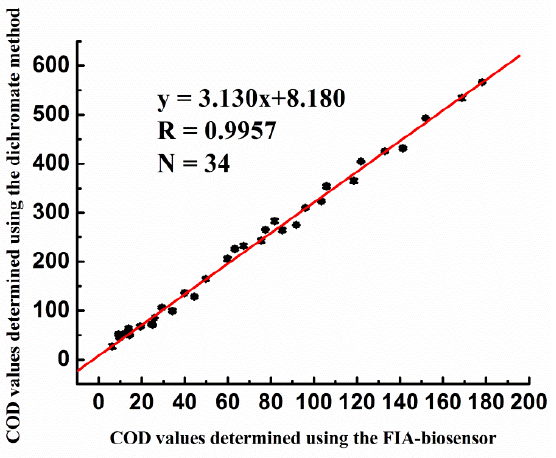
Figure 9. Graph showing the correlation between the COD values obtained using the FIA biosensor and those obtained using the dichromate